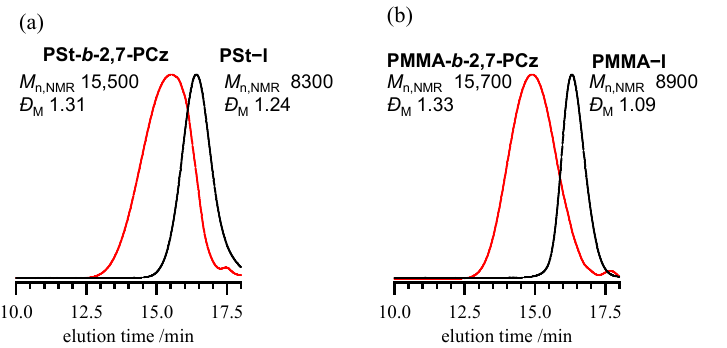
Figure 11. SEC traces of ( a ) PSt- b -2,7-PCz and ( b ) PMMA- b -2,7-PCz. The black and red curves represent the macroinitiators and block copolymers, respectively.